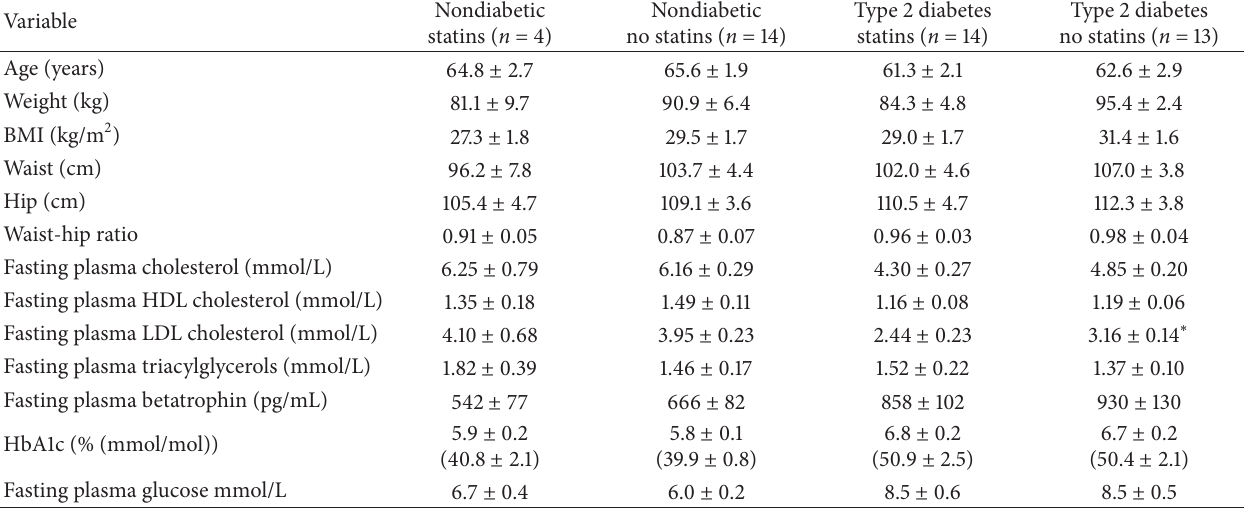
Table 3: Descriptive data and blood sample data for nondiabetic controls and patients with type 2 diabetes with or without statin treatment. Comparisons were made within groups, that is, nondiabetic controls with statin treatment versus nondiabetic controls without statin treatment and type 2 diabetes patients with statin treatment versus type 2 diabetes patients without statin treatment. HbA1c levels are given as NGSP (%) with IFCC values (mmol/mol) in